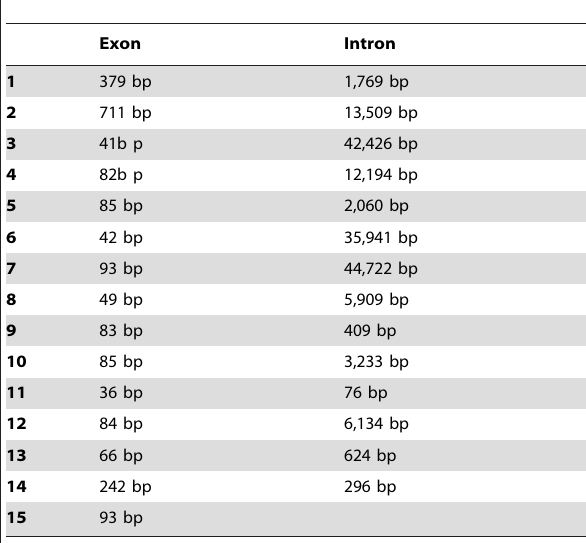
Table 1. Intron and Exon sizes of Rbp6 splice isoform A.